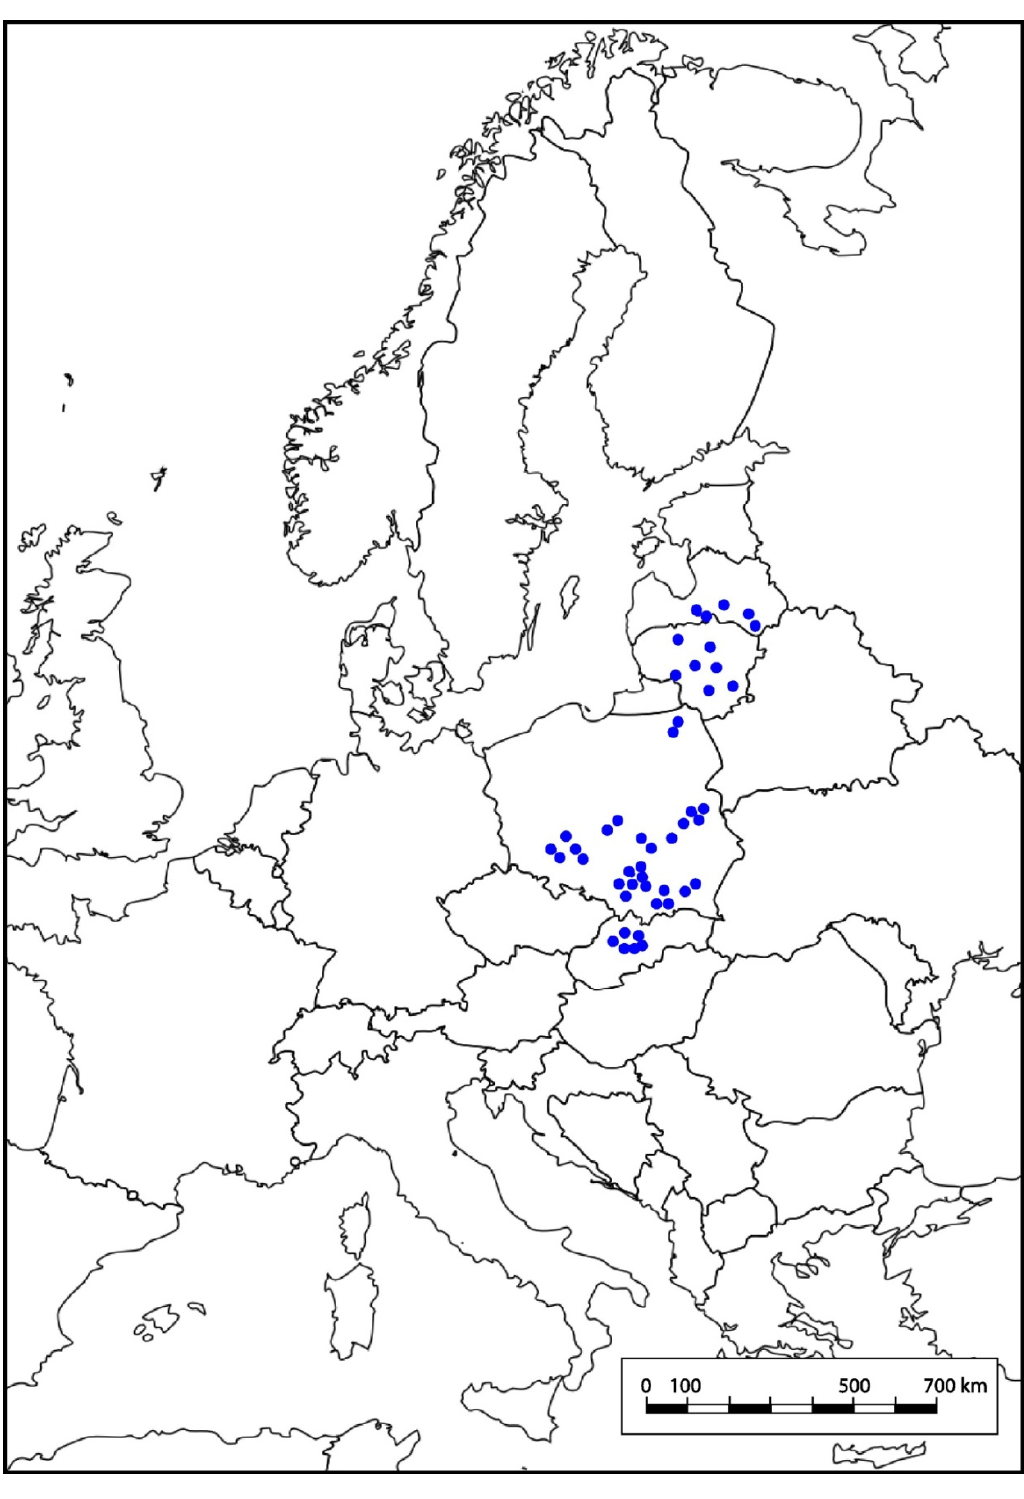
Figure 2. Distribution of sampled populations of Echinocystis lobata.